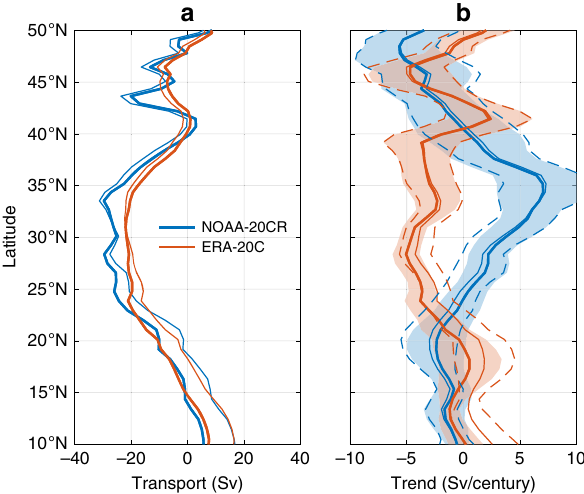
Fig. 6 Changes in wind-stress curl and gyre circulation. a Thick lines are time-mean geostrophic Sverdrup streamfunction 9 based on wind-stress curl from NOAA 20CR 61 and ERA 20C 62 reanalyses over 1900 – 2010 as a function of latitude in the North Atlantic. Thin lines are the same, but also incorporate the ageostrophic Ekman transport integrated across the basin. b Median estimates (thick lines) and formal 95% con fi dence intervals (colored shading) of the trend in Sverdrup streamfunction versus latitude during 1900 – 2010 from the two reanalyses. Thin and dashed lines represent median estimates and con fi dence intervals, respectively, with Ekman transports also